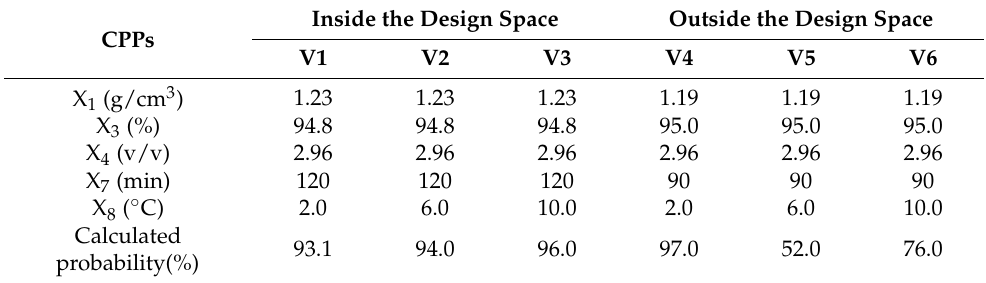
Table 2. The CPPs of the verification experiments. X 1 : density of the concentrated extract; X 3 : ethanol